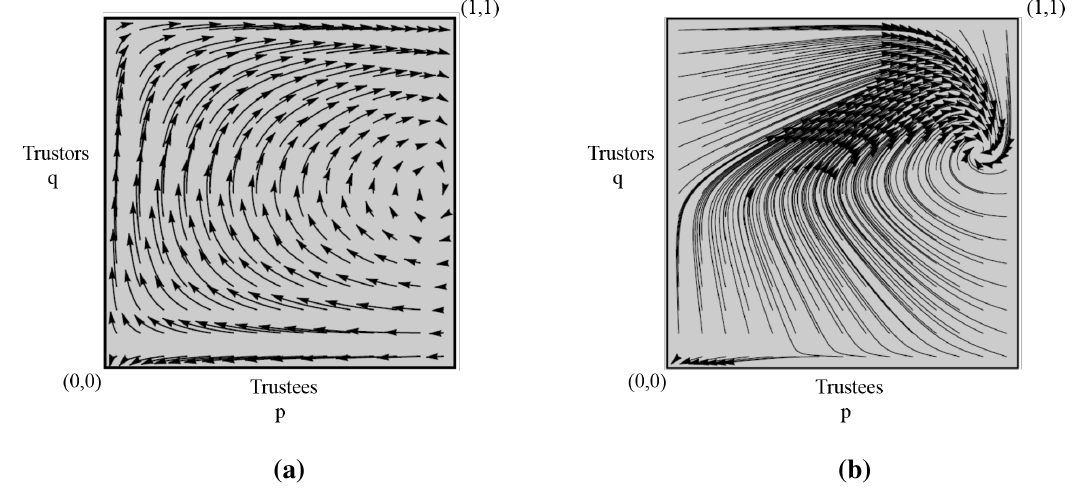
Figure 3. Evolutionary dynamics of the game under moral codes ( e = 0 . 05 , v = 2 c = 1 ). ( a ) Replicator; ( b ) Logit ( η = 0 . 1